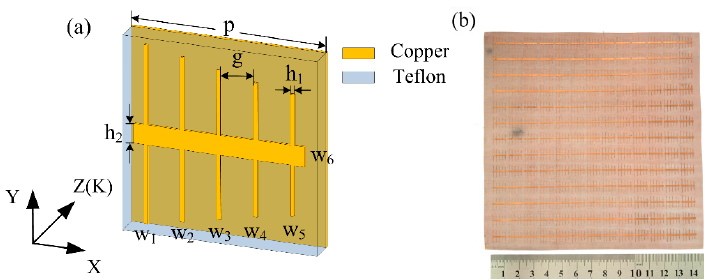
Figure 1. ( a ) Unit cell schematic diagram of the proposed absorber; ( b ) Photograph of fabricated prototype.